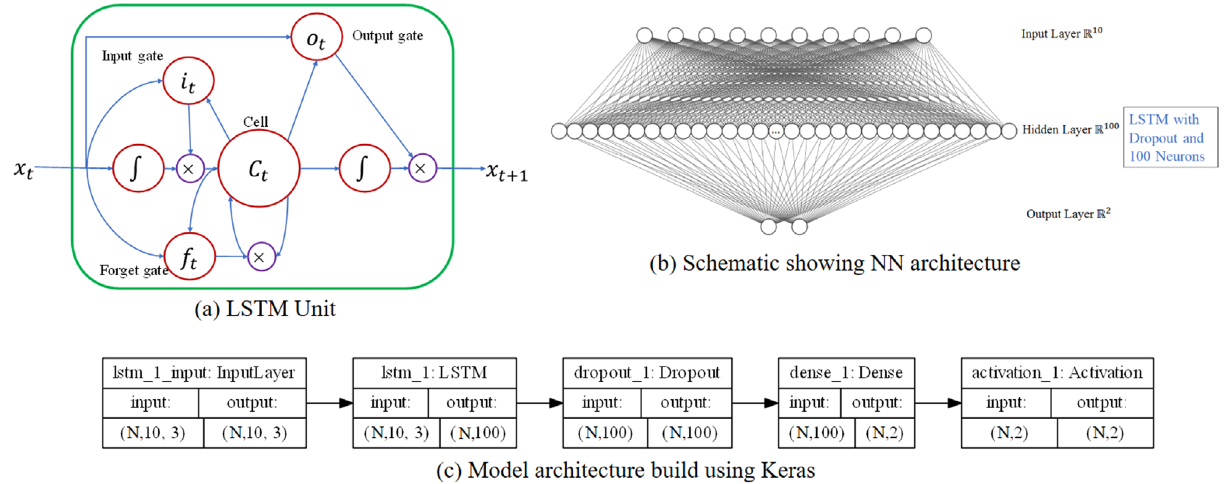
Fig. 4. Schematics showing architectures (a) of a single LSTM block, (b) of the classi fi er consisting of one input layer, one LSTM layer consists of 100 nodes (neurons), dropout, and output layer, and (c) of the classi fi er model implemented using Keras.